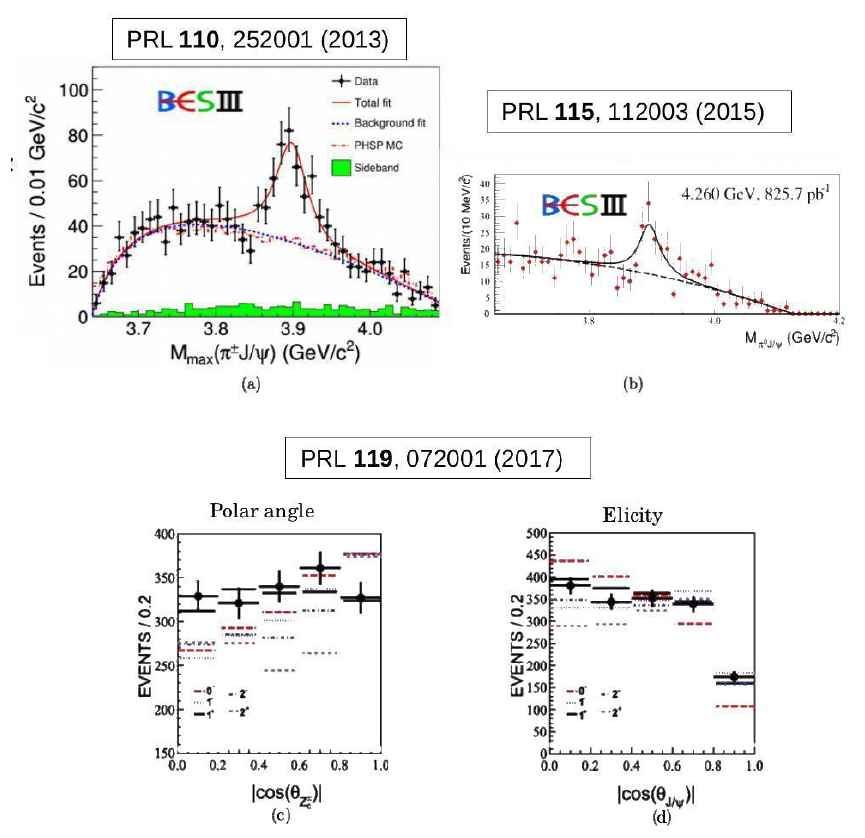
Figure 2. Summary of the plots of interest for the Z (3900). On the top the invariant mass spectrum of the Z (3900) with a charged (neutral) pion is shown (a and b). On the bottom the polar angle and elicity distribution used to define its quantum number (c and